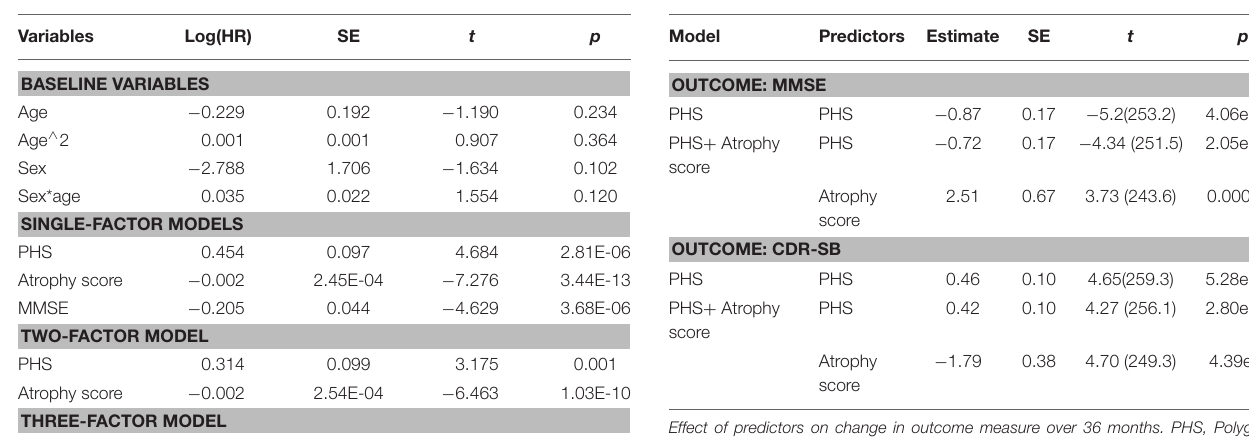
TABLE 4 | Prediction of clinical